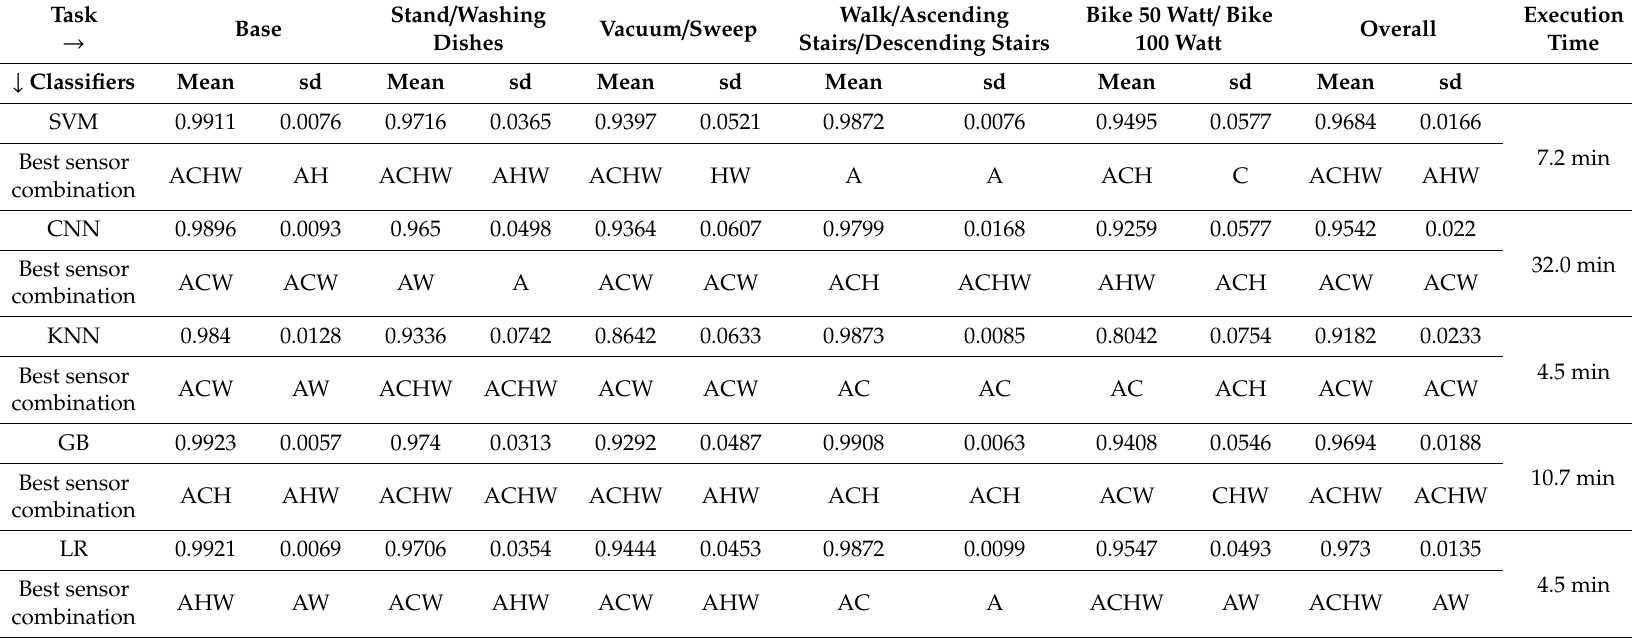
Table 2. Best mean (maximum) and standard deviation (minimum) of accuracy score by classification task and